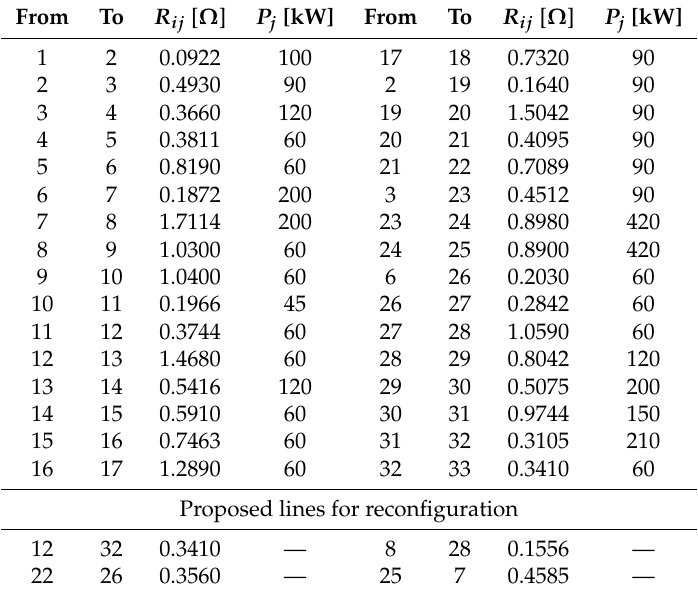
Table 7. Electrical parameters for the 33-nodes test system.